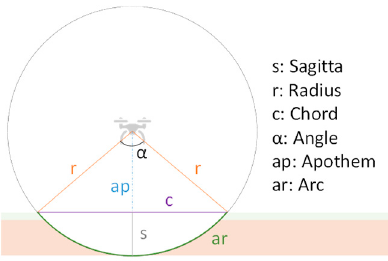
Figure 2. Area covered by the sensor antenna located on the drone: ( a ) Omnidirectional antenna case, ( b ) Directional antenna case.